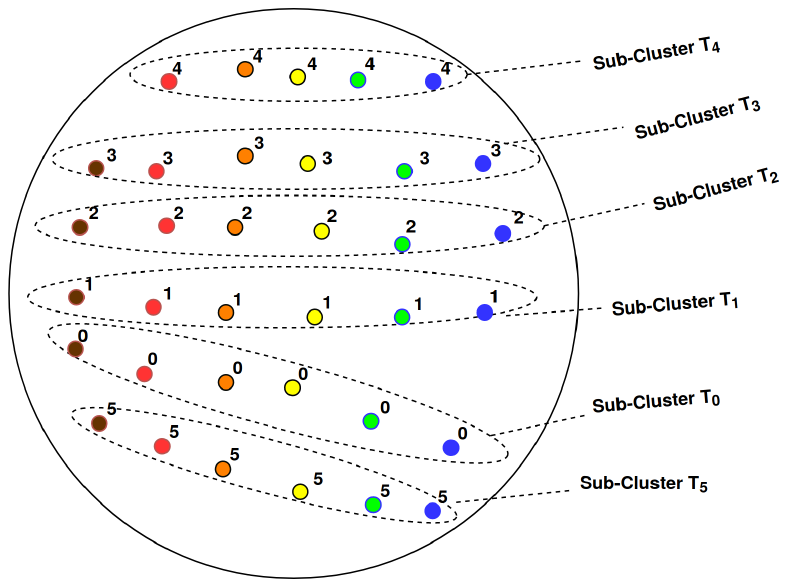
Figure 3. Decomposition of a cluster into